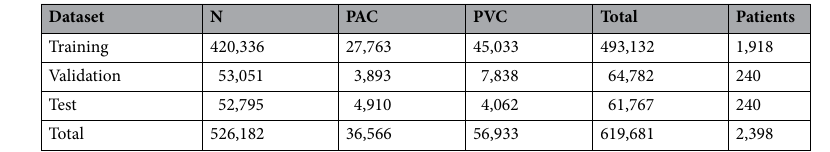
Table 1. QRS complex counts in the private MDT data for model training, validation and test. N normal sinus QRS, PAC premature atrial contraction, PVC premature ventricular contraction.